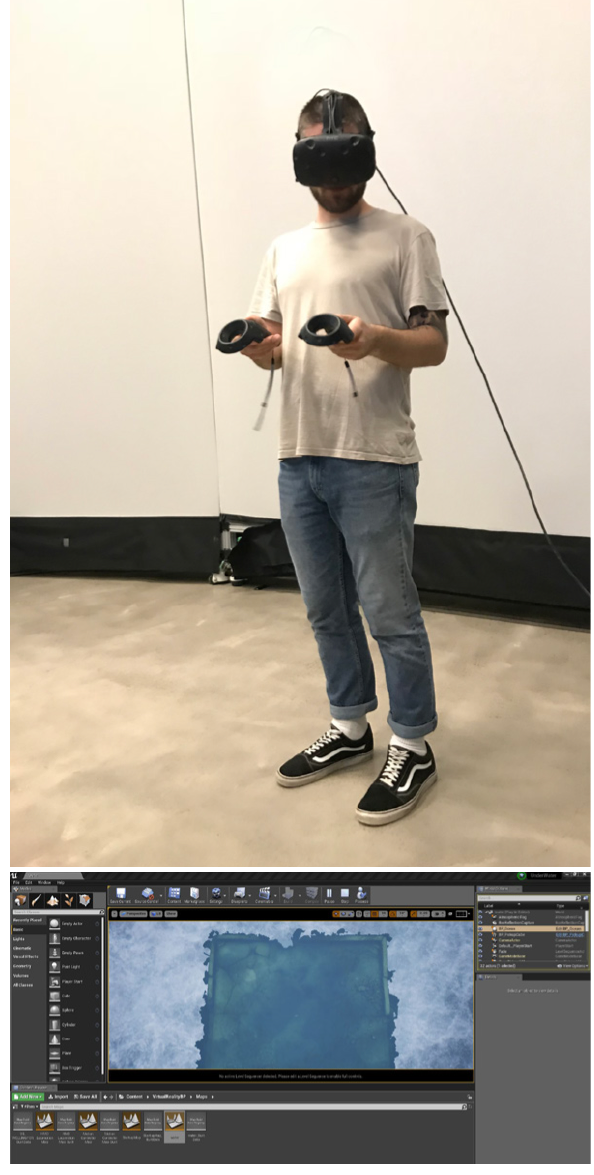
Figure 13. Robert Duncan Immersed in a Virtual Heritage